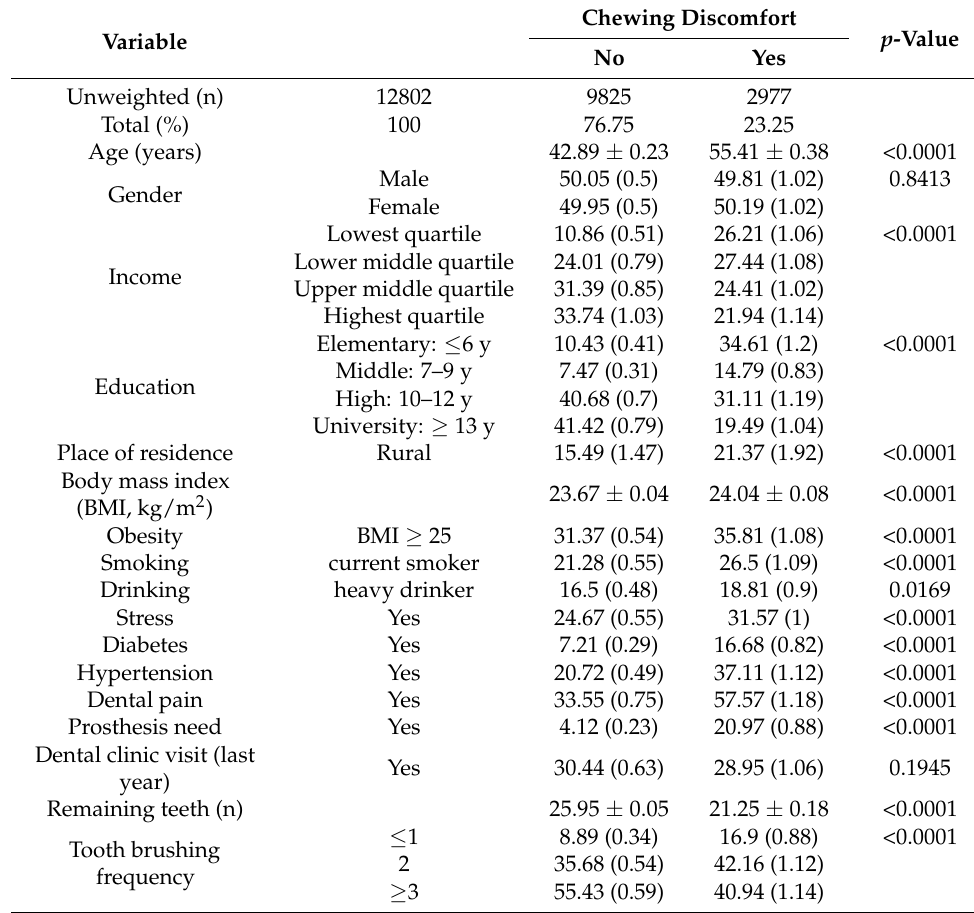
Table 1. General characteristics of participants with and without chewing discomfort.